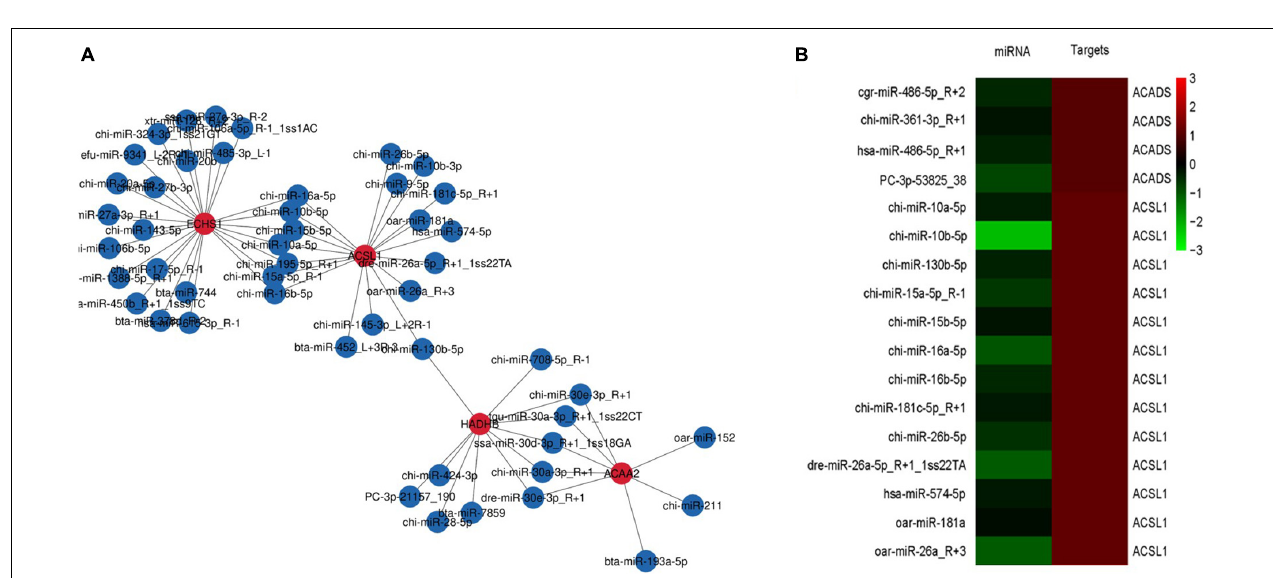
FIGURE 3 | Differentially expressed miRNAs (DEMs) in skeletal muscle in the high-fatty acid group and the low-fatty acid group. (A) Heatmap of the significant DEMs. Red represents significant upregulation, while blue represents significant downregulation. (B) KEGG analysis of the targets of DEMs related to fatty acid metabolism.